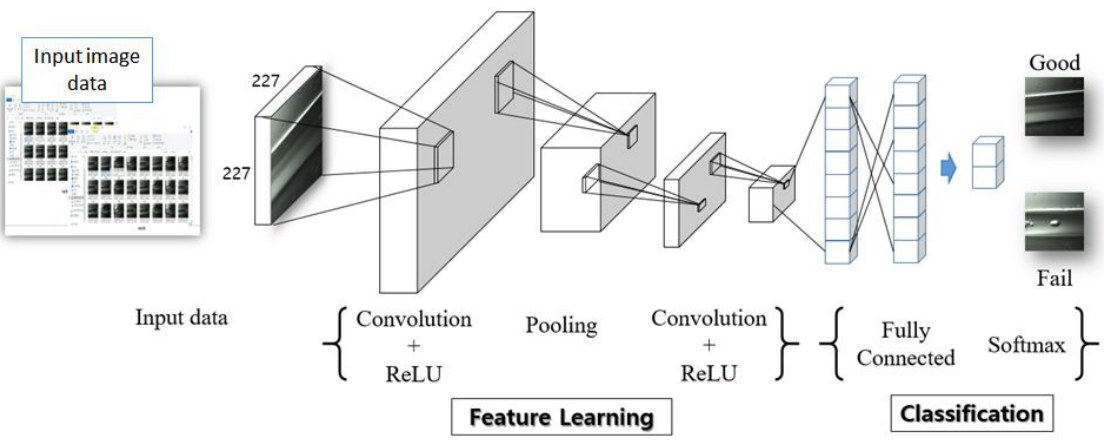
Figure 4. Structure of the deep learning